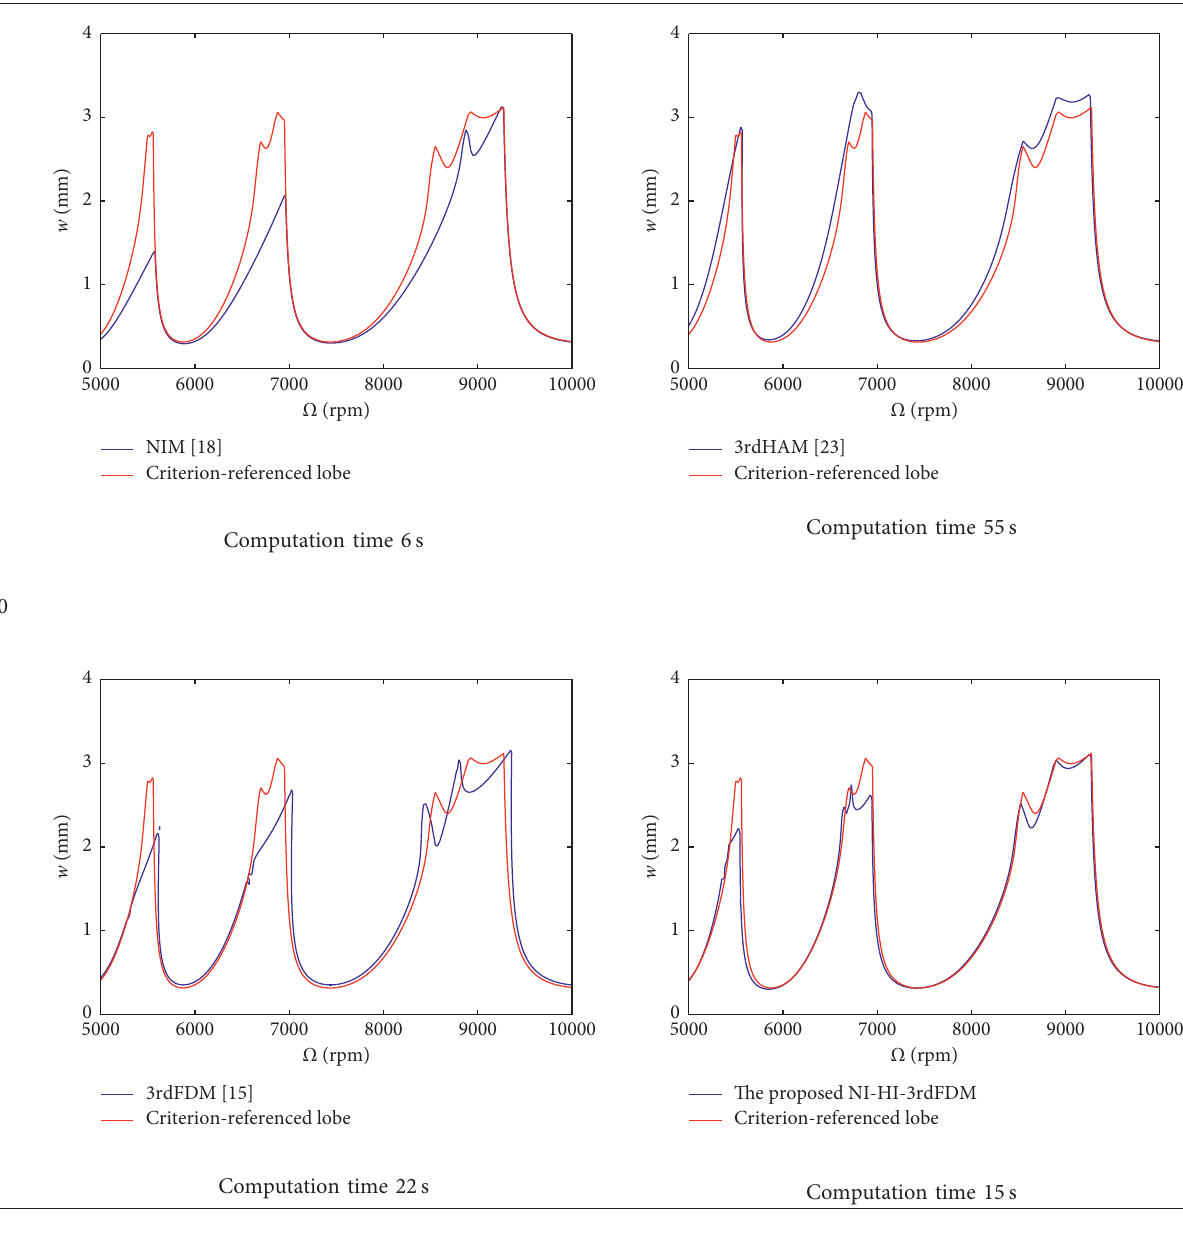
Table 3: SLD for the single DOF milling model using the NIM, 3rdHAM, 3rd FDM, and the proposed